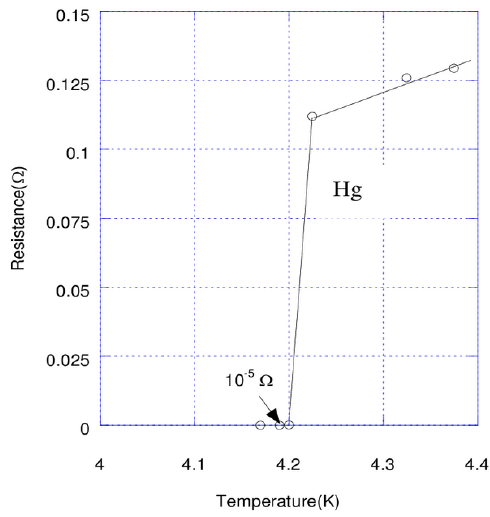
Figure 1. Superconductive characteristic of mercury [2].